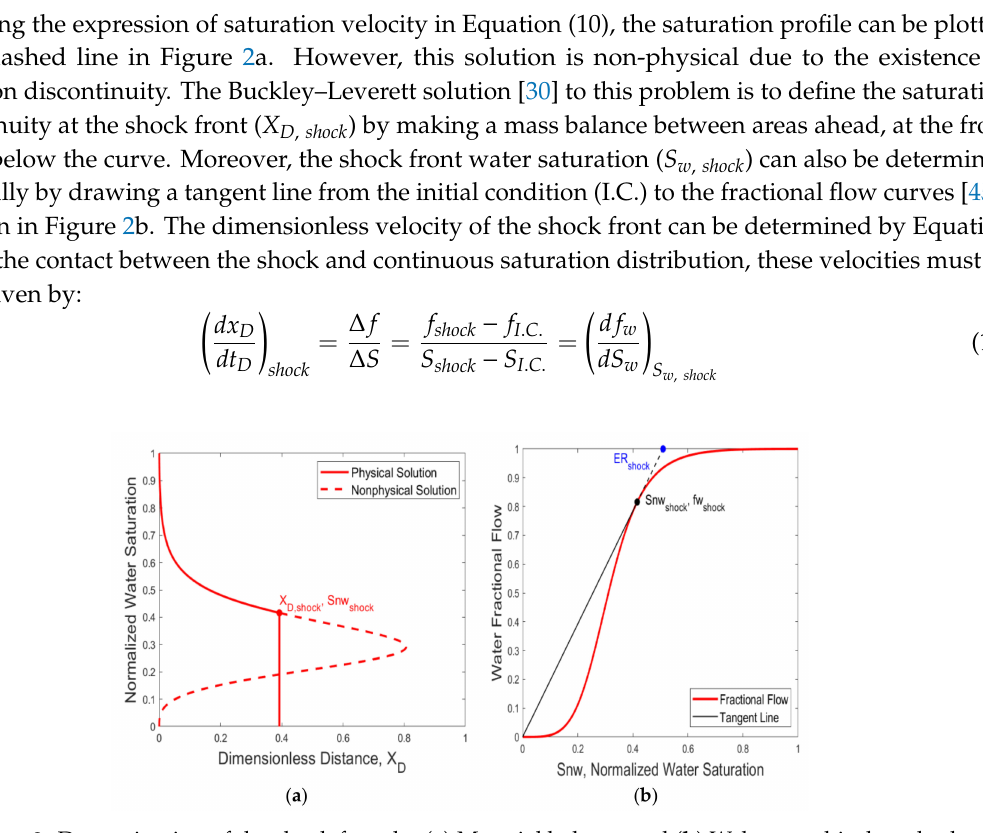
Figure 2. Determination of the shock front by ( a ) Material balance and ( b ) Welge graphical method, parameters are listed in Table